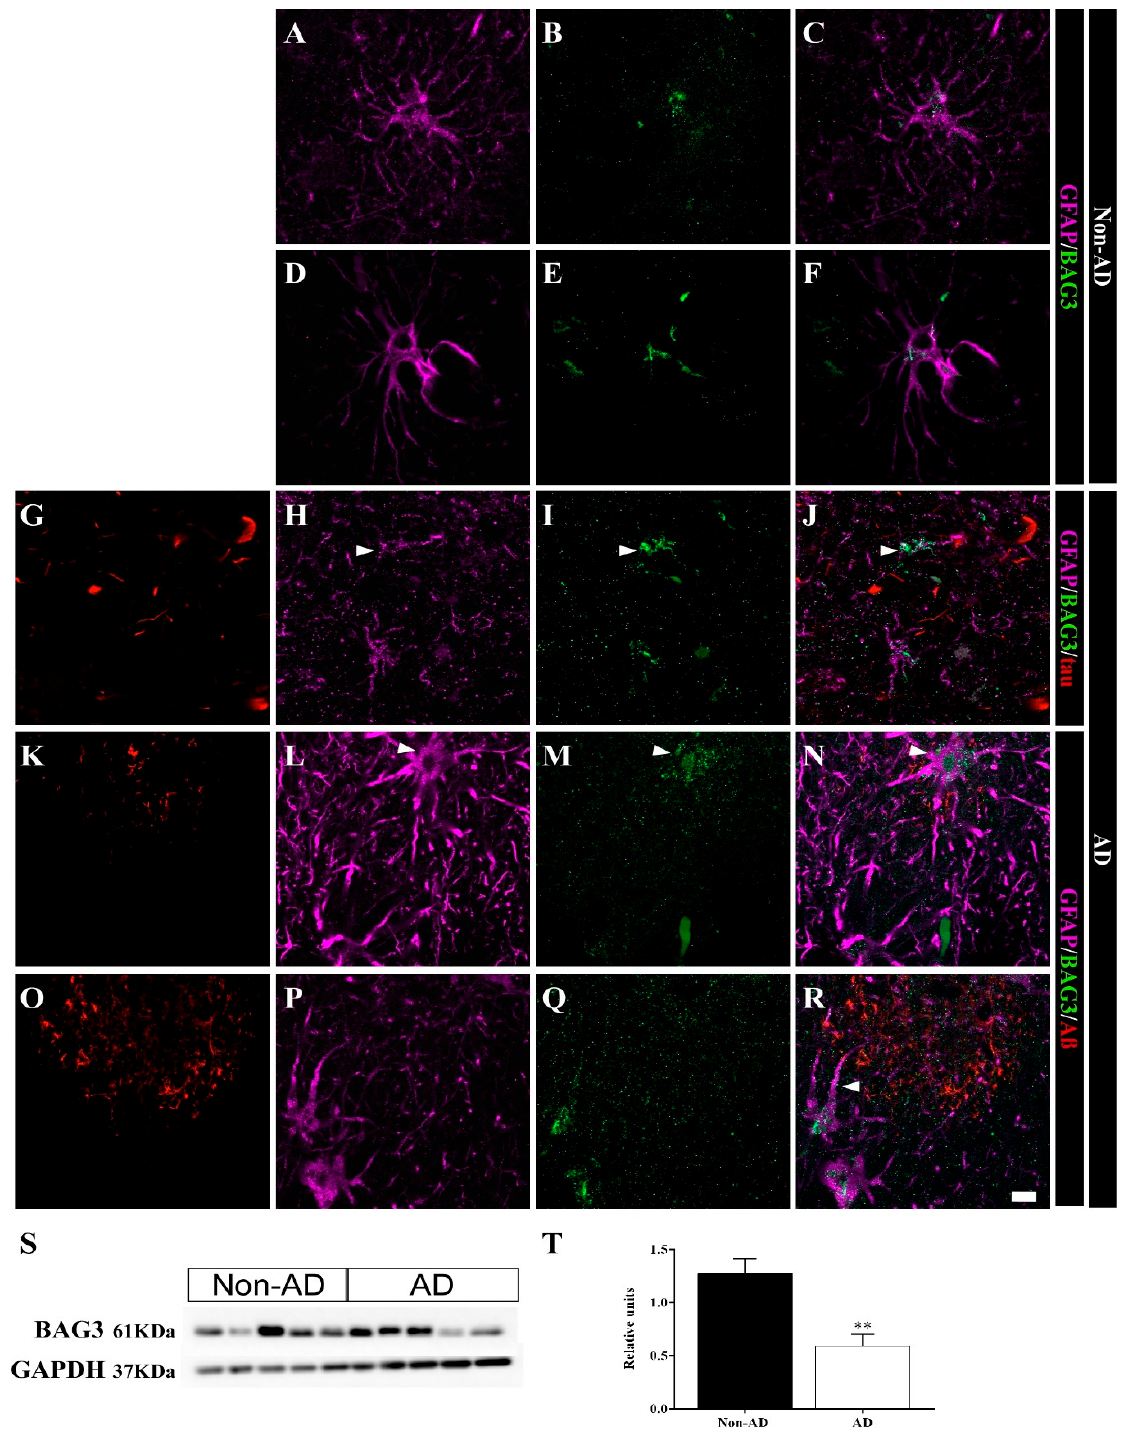
Figure 9. BAG3 is expressed in astrocytes in the human HIPP. Confocal analyses of GFAP ( violet ), BAG3 ( green ) and tau or A β ( red ) expression in the CA1 region in non-AD ( A – F ) and AD ( G – R ) samples. BAG3 was found in astrocytes in both non-AD samples ( A – F ) and overexpressed in AD samples ( G – R ). Some astrocytes showed mainly BAG3 staining instead of GFAP staining ( H – J , arrowhead). BAG3 released within and around plaques was frequently observed ( K – R ). ( S , T ) BAG3 expression throughout the whole human HIPP was evaluated by WB (the graph shows the mean ± SEM, ** p value < 0.01). Scale bar = 10 µm.